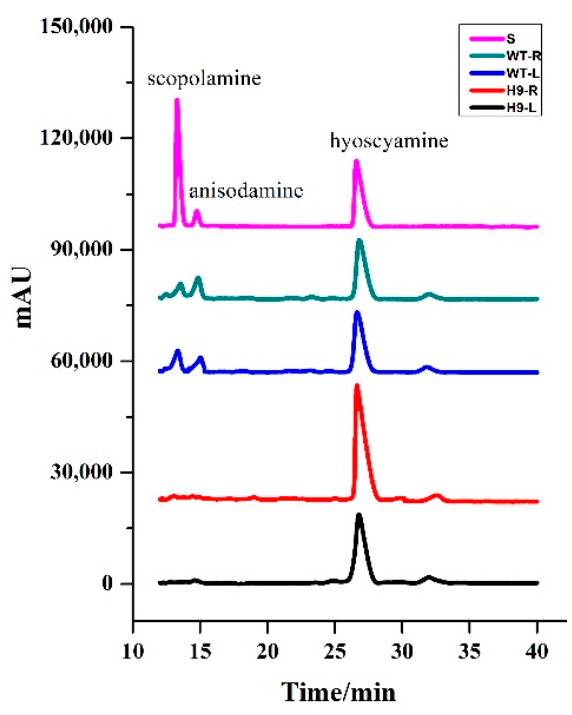
Figure 4. HPLC trace of tropane alkaloids in Atropa belladonna plants. S, standard samples; WT-R, roots of wild type plants; WT-L, leaves of wild type plants; H9-R, roots of transgenic plants; H9-L, leaves of transgenic plants.